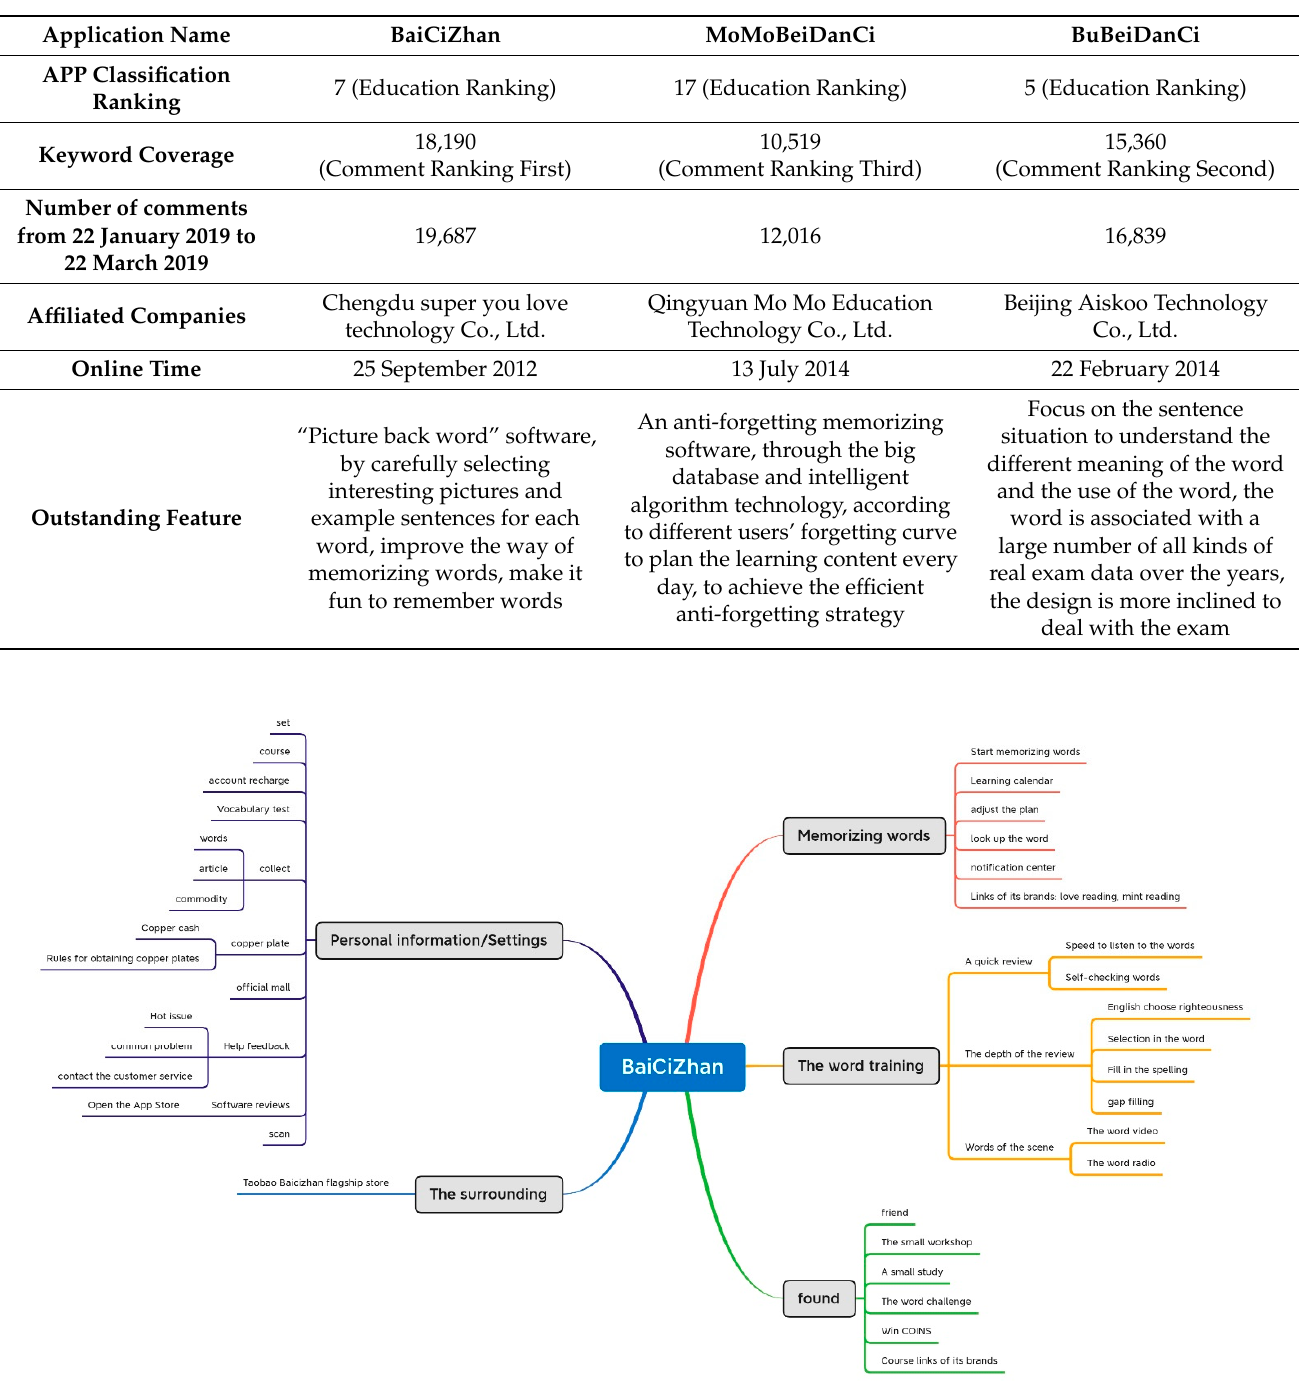
Figure 1. Distribution of BaiCiZhan APP modules.